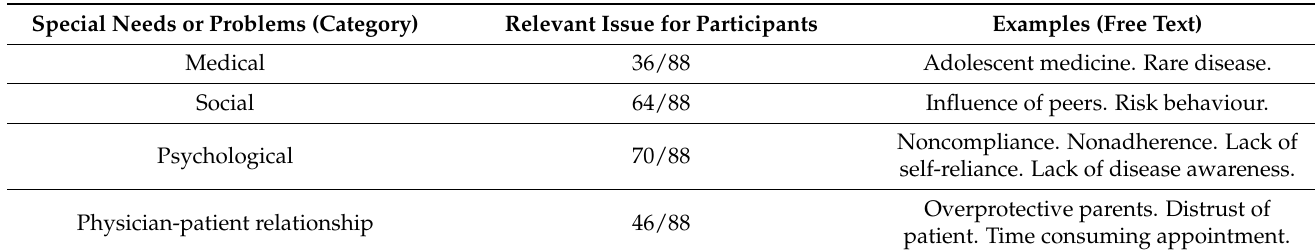
Table 2. Frequency of categories and free text examples regarded as relevant challenges to transition by 88 adult nephrologists in a short online